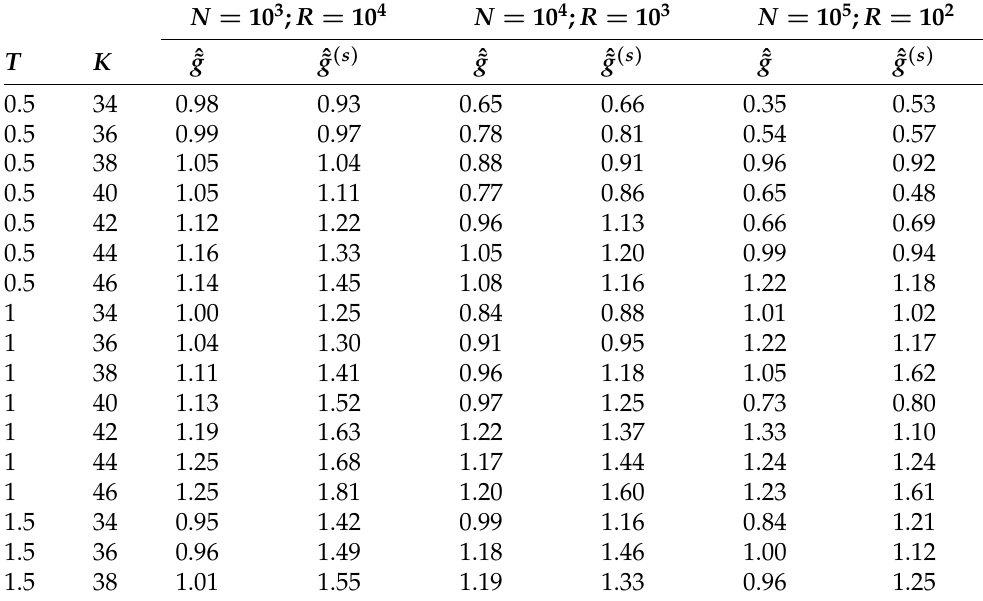
Table A6. Detailed RMSE efficiency results with GHS